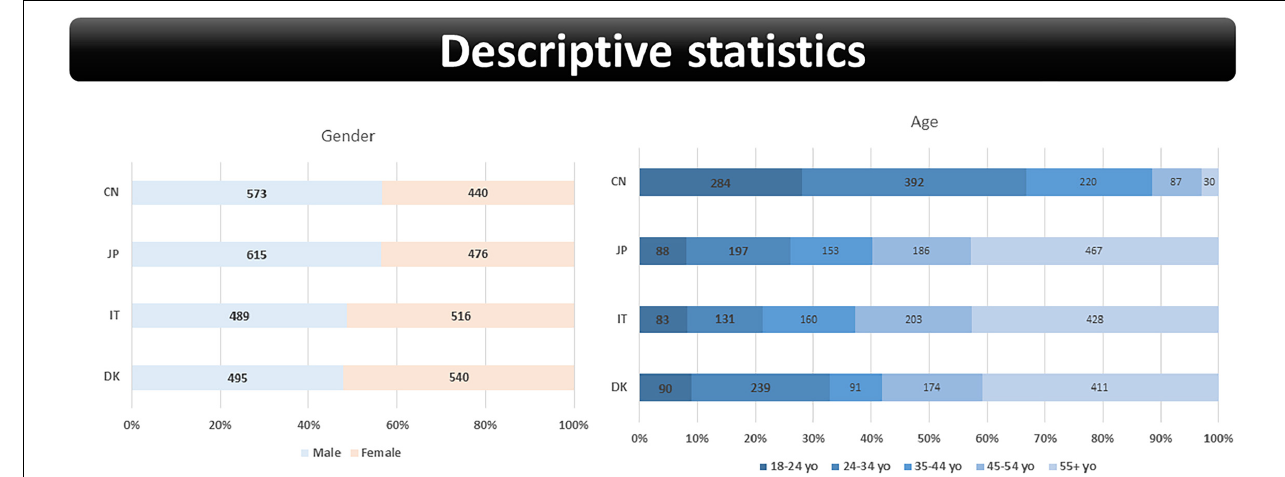
FIGURE 1 | Gender and age of the